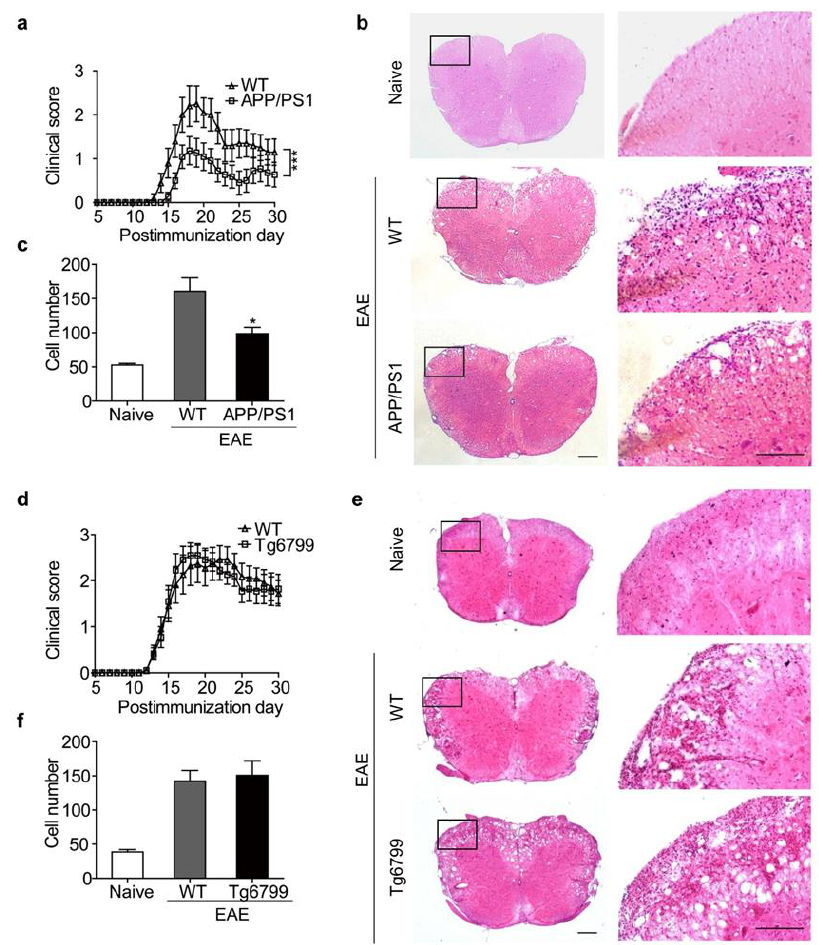
Figure 1. Clinical symptoms of EAE in APP/PS1 and Tg6799 transgenic mice. ( a ) Clinical scores of EAE in WT and APP/PS1 mice. Results are presented as daily mean clinical scores ± SEM. *** p < 0.001, two-way ANOVA (WT, n = 10; APP/PS1, n = 11). ( b ) Hematoxylin and eosin (H&E)- stained slides of spinal cords from naive, WT, and APP/PS1. ( c ) Quantification of infiltrating cells. Data are mean ± SEM, * p < 0.05 (Student’s t -test). ( d ) Clinical scores of EAE in WT and Tg6799 mice ( n = 11 per group). ( e , f ) H&E staining was performed to analyze infiltrating cells. The boxed areas in the left columns are presented enlarged on the right. Scale bars, 200 µ